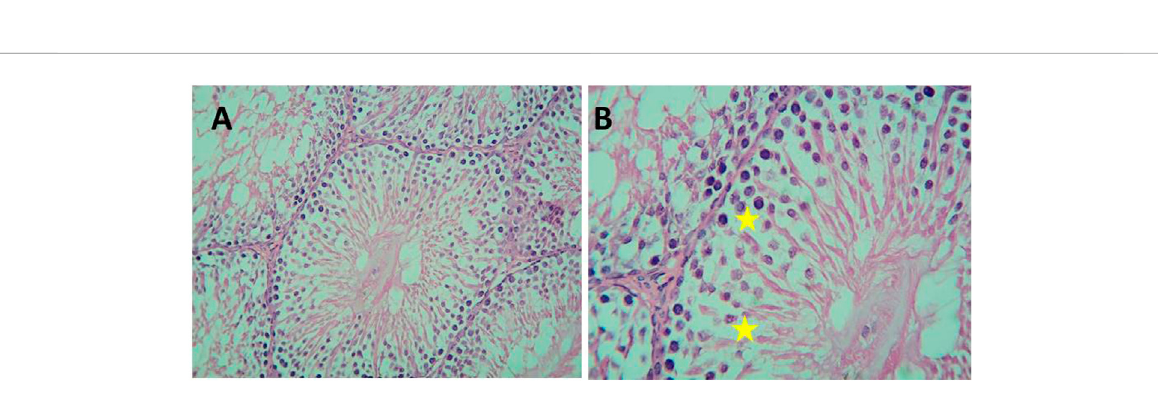
intercellular spaces (Figures 5A,B). Spermatocytes (SC) showed focal nuclear-chromatin condensation, occasional electron-dense inclusion bodies (IB), and subtle variation in the sizes of sER